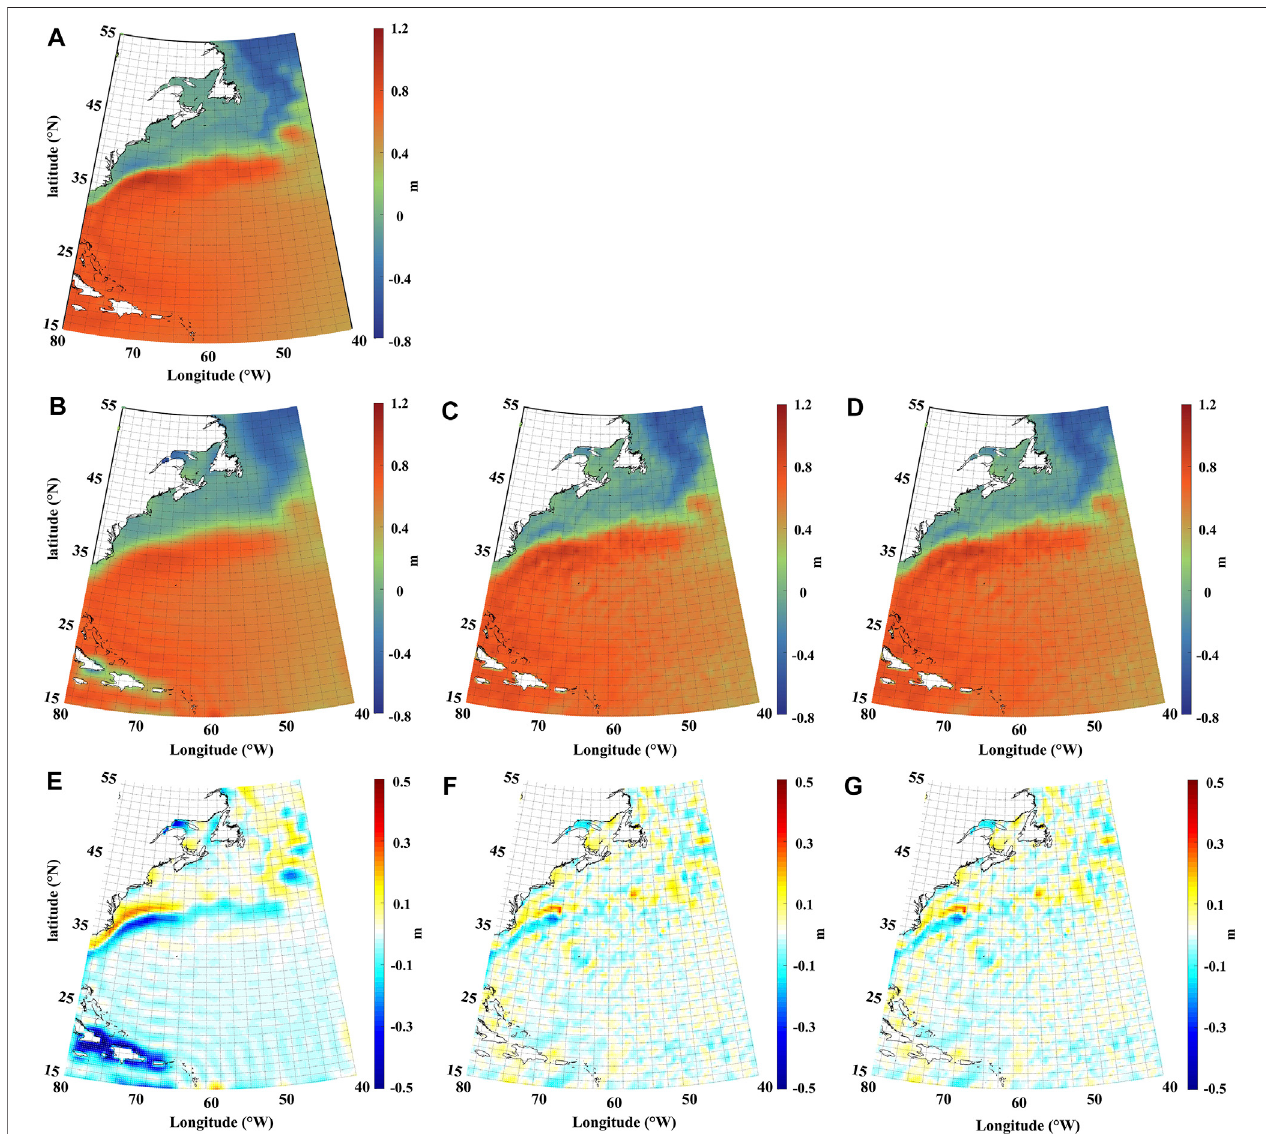
FIGURE 2 | (A) the Synthetic_MDT; (B) the Gaussian fi ltered MDT; estimated MDT with (C) full error information, and (D) diagonal error information of GGM; and (E – G) are the corresponding mis fi ts between (B – D) against the Synthetic_MDT, respectively.